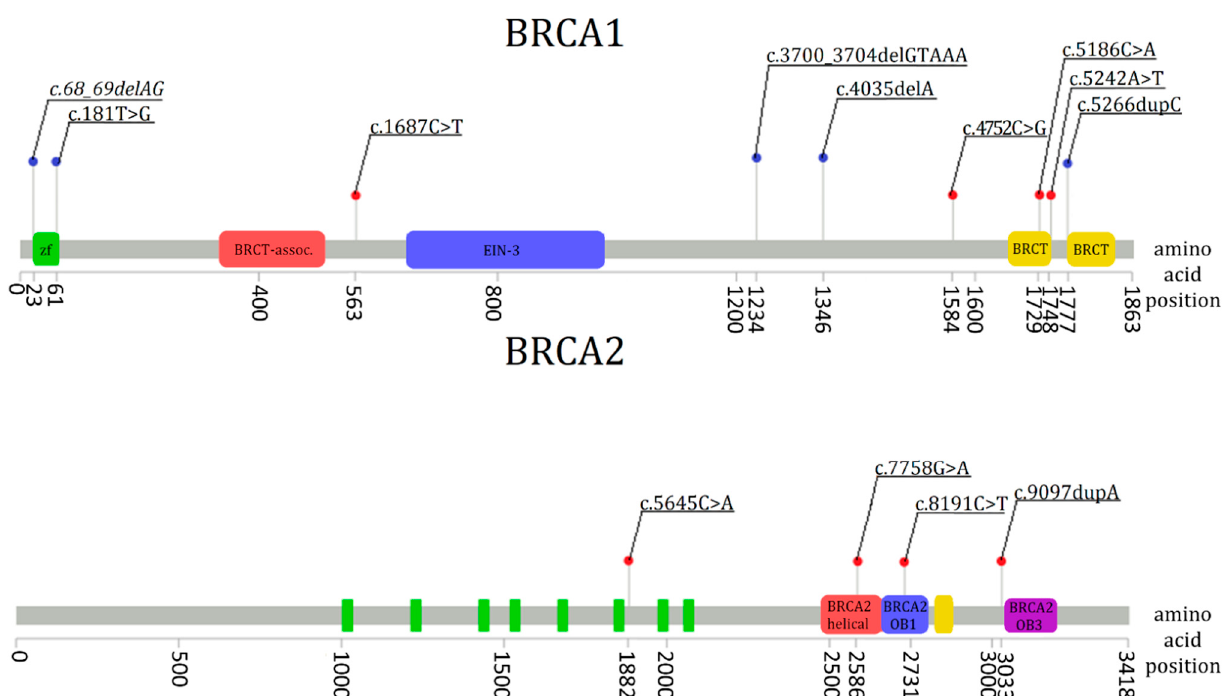
Figure 1. 5 BRCA1 recurrent mutations in the Polish population (blue dots) and pathogenic variants detected in the BRCA1 and BRCA2 genes (red dots). Five known mutations in BRCA1 : c. 68_69delAG, c.181T>G, c.3700_3704delGTAAA, c.4035delA, c.5266dupC. Nine pathogenic variants detected in the study group: c.1687C>T ( BRCA1 ), c. 4752C>G ( BRCA1 ), c.5186C>A ( BRCA1 ), c.5242A>T ( BRCA1 ), c.5645C>A ( BRCA2 ), c.7758G>A ( BRCA2 ), c.8191C>T ( BRCA2 ) and c.9097dupA ( BRCA2 ). BRCA1 domains: zf—zinc finger C3 ‐ HC4; CRCT ‐ assoc.—serine ‐ rich domain associated with BRCT; EIN ‐ 3—ethylene ‐ insensitive 3; BRCT—BRCA1 C terminus domain. BRCA2 domains: BRCA2 ‐ helical; BRCA2 ‐ OB1—oligonucleotide/oligosaccharide binding domain 1; BRCA2 ‐ OB3—oligonucleotide/oligosaccharide ‐ binding domain 3.